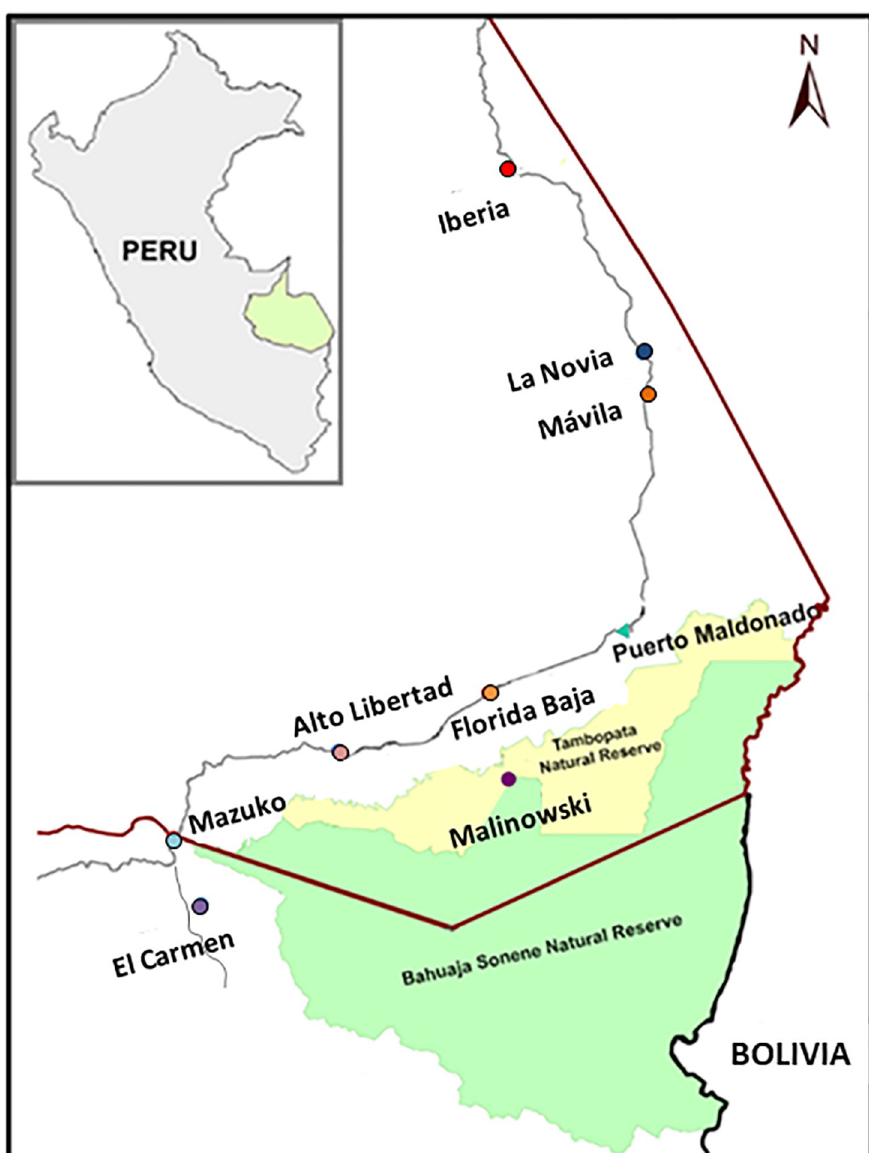
Fig 1. Map of the study area. Figure illustrates the Peru and Bolivia border, highlighting Madre de Dios state (Peru) crossed by the interoceanic highway. Study sites are coloured depending on the degree of human impact in red (high impact), blue (low impact) and purple (undisturbed) circles, while the state capital (Puerto Maldonado) is in green. The map was created using open data obtained from OpenStreetMap URL: